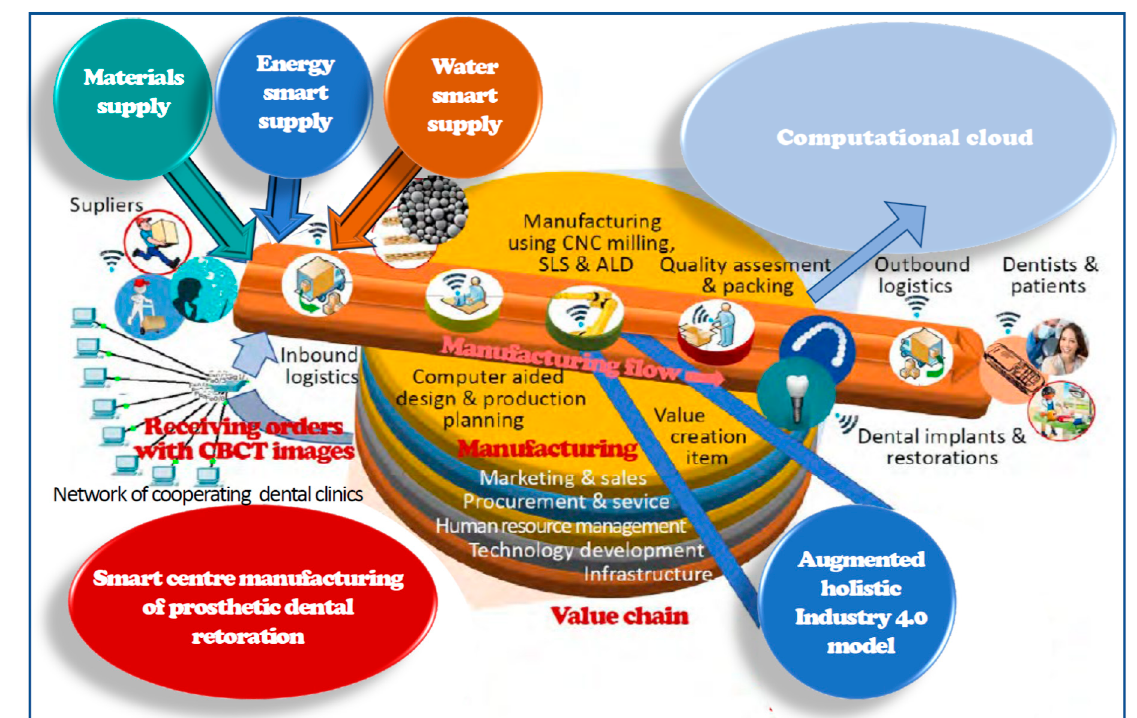
Figure 22. Diagram of an example technological line in intelligent centers produces dental prosthetic restorations, including horizontal and vertical integration.